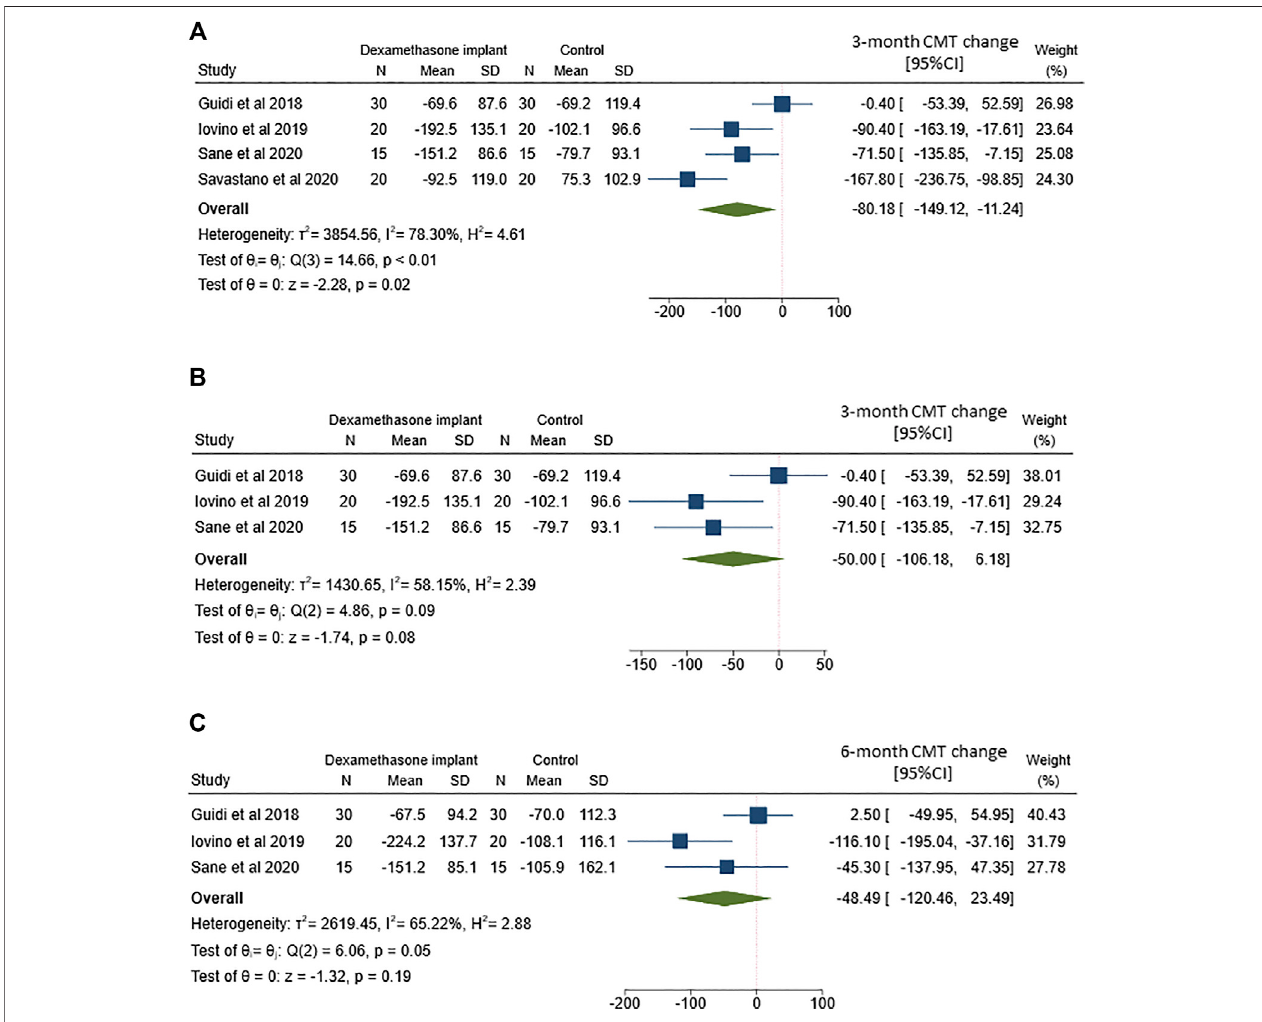
FIGURE 3 | Forest plots of the comparison of mean central macular thickness (CMT) change between vitrectomy with and without intravitreal dexamethasone implant (A) CMT change assessed at 3-months follow-up (B) Sensitivity analysis of CMT change at 3-months follow-up by excluding the study by Savastano and coworkers (C) CMT change assessed at 6-months